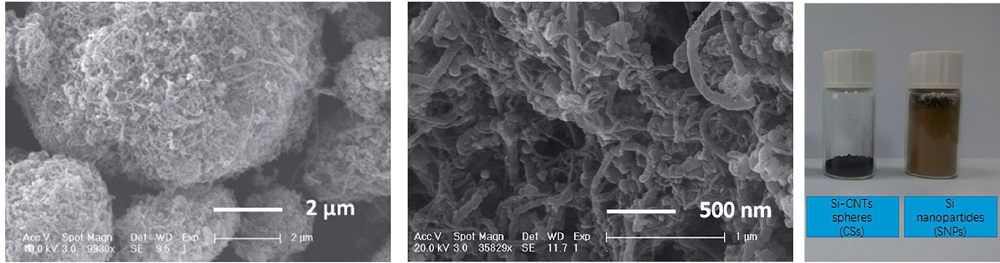
Figure 7. ( left and middle ) SEM images of Si/carbon nanotubes (CNT) composite microspheres; ( right